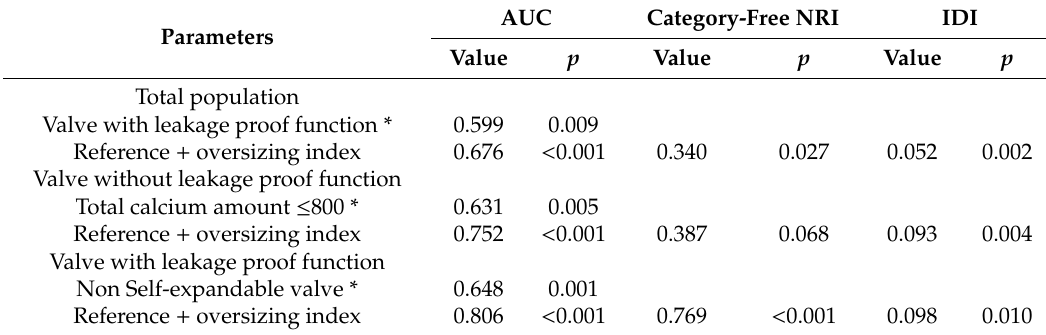
Table 5. Incremental value of oversizing index over reference value for predicting no PVL.